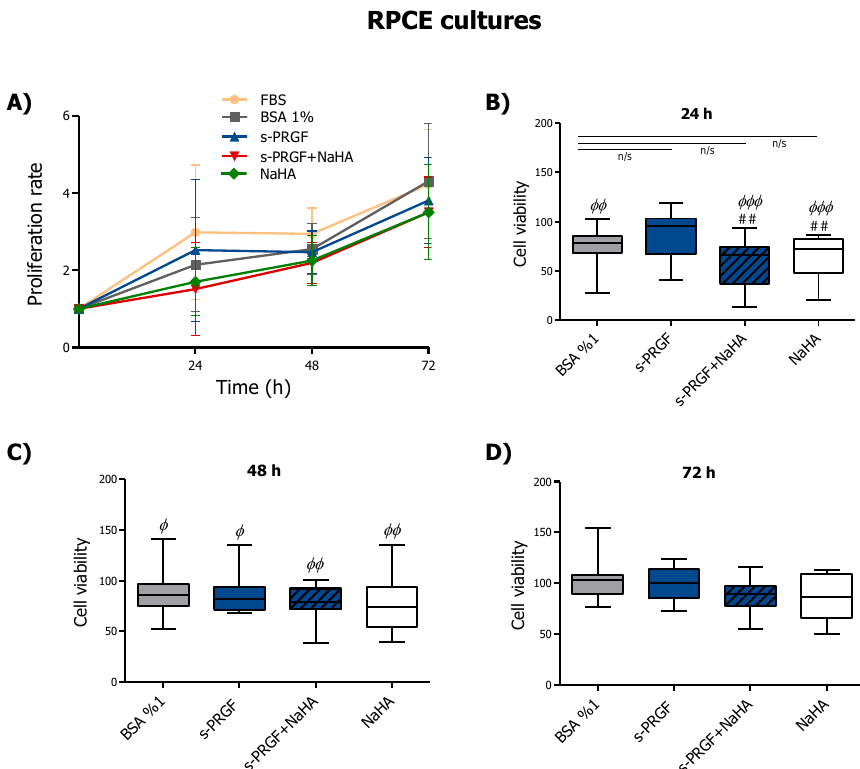
Figure 1. Effect of serum derived from plasma rich in growth factors (s-PRGF), alone or combined with sodium hyaluronate (NaHA), ( A ) on the proliferation and ( B – D ) viability of rabbit primary corneal epithelial (RPCE) cultures. Cultures were exposed for 24, 48, and 72 h to 10% FBS; 45% s-PRGF; 45% s-PRGF and 0.1% NaHA (combined treatment); 0.1% NaHA; and 1% BSA as a negative control. Proliferation results are expressed as proliferation rate ± standard deviation of viable cells with respect to viable cells at t = 0. Viability results are expressed as percentages versus that with FBS (100% viability). Statistically significant differences with respect to FBS ( Φ ) or to s-PRGF (#) (## p < 0.01; Φ p < 0.05; ΦΦ p < 0.01; ΦΦΦ p < 0.001; n/s, not significant. Kruskal-Wallis test, Dunn test with Bonferroni correction to Multiple